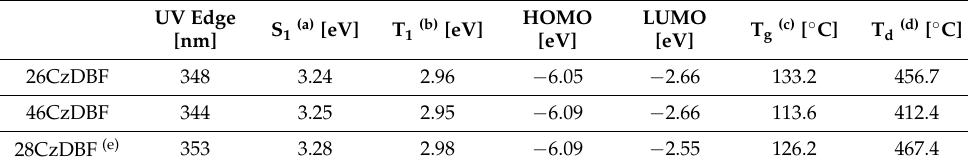
Table 1. Summarized material parameters of 26CzDBF, 46CzDBF, and